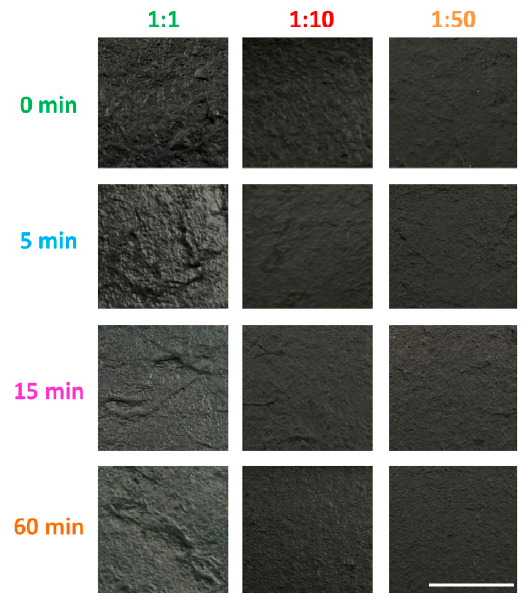
Figure 2. Photographs of all CNT films (with EC). All the photographs were taken at the same magnification and the white marker is 1 cm long.